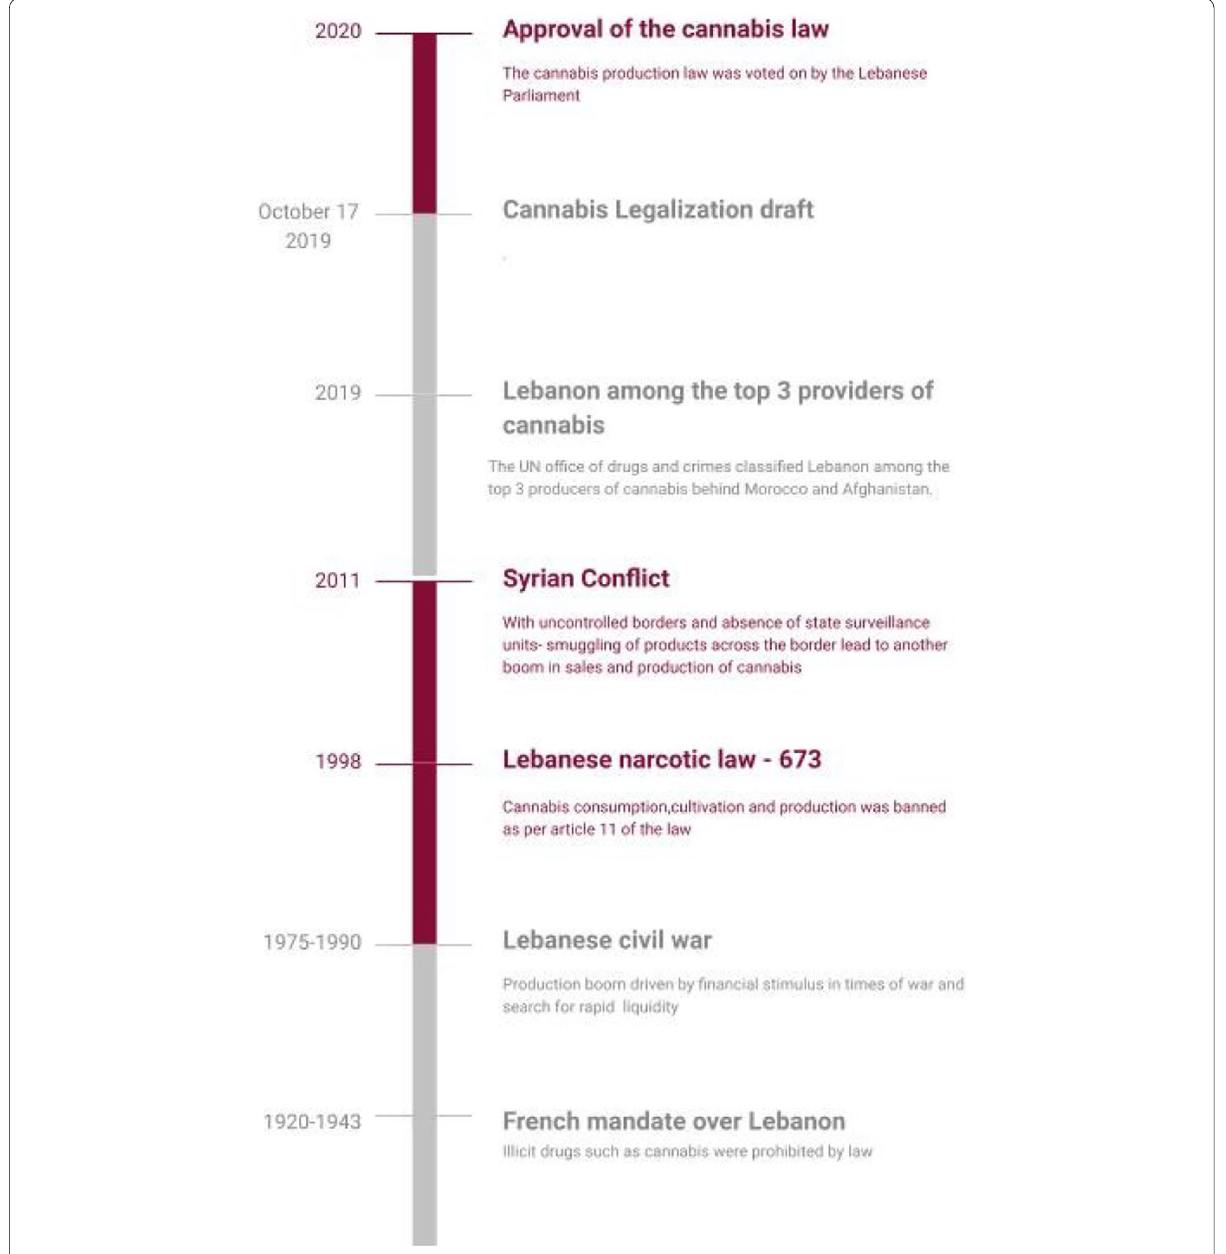
Fig. 1 Cannabis historical timeline in